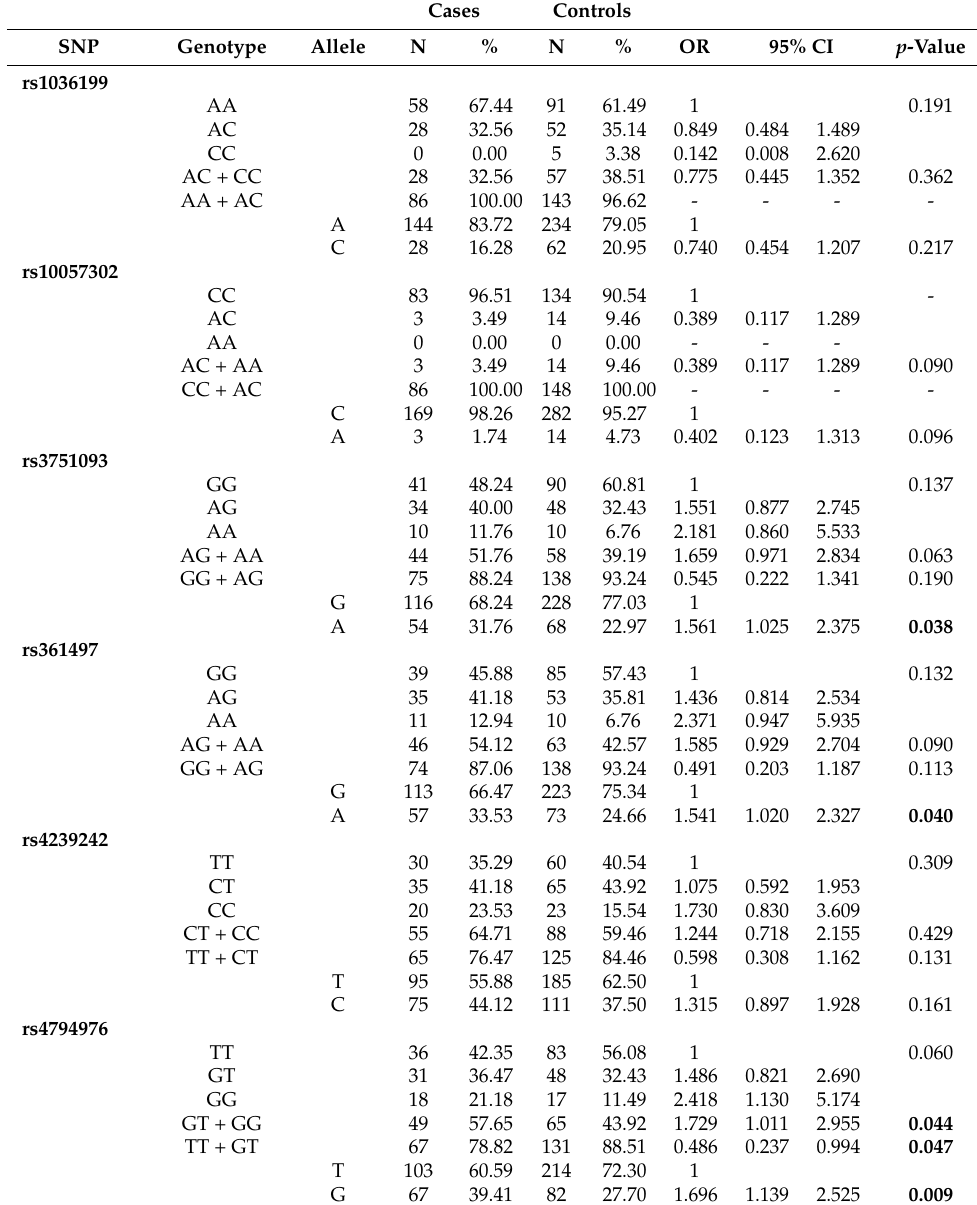
Table 2. Genotype and allele distribution of TIM-3 and LGALS9 SNPs among female patients and female